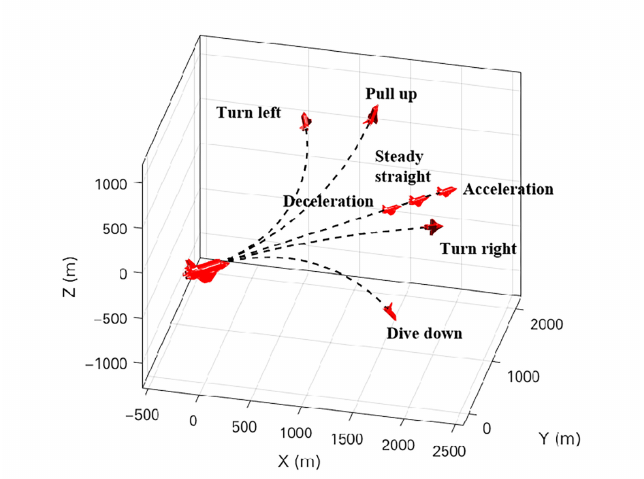
Figure 5. Seven basic maneuvers.